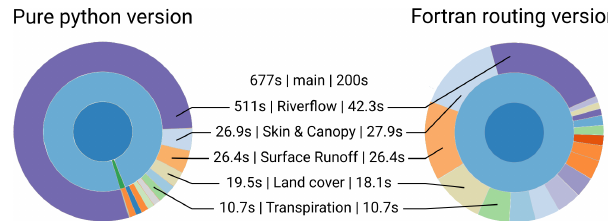
Figure 3. Sunburst graphs depicting the distribution of model run- time for a global simulation of 1 year at 0.5 ◦ resolution without writing any output. Both simulations were conducted on a sin- gle node of a high-performance Linux cluster (using an Intel(R) Xeon(R) Platinum 8160 CPU with 2.10GHz). Values are shown for the pure Python version (left) and the version using Fortran for river routing (right). The visualization was done using Snake- viz (https://jiffyclub.github.io/snakeviz/, last access: 10 December 2020). Note that as HydroPy currently does not utilize paralleliza- tion, the runtimes on a standard office laptop are roughly the